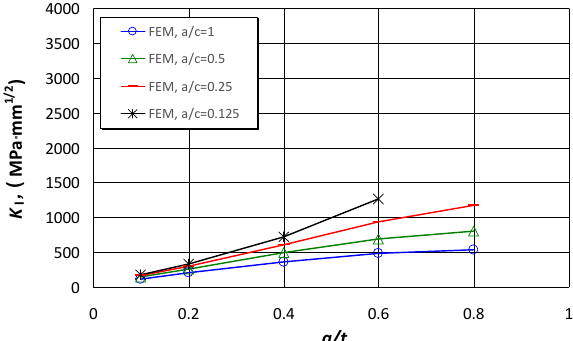
Figure 11. SIF solutions for crack oriented at α = 30°.